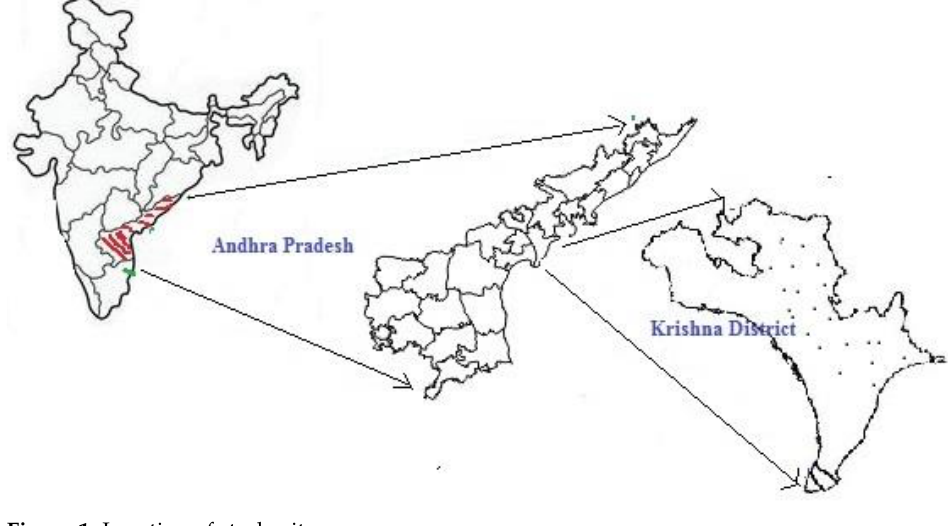
Figure 1. Location of study